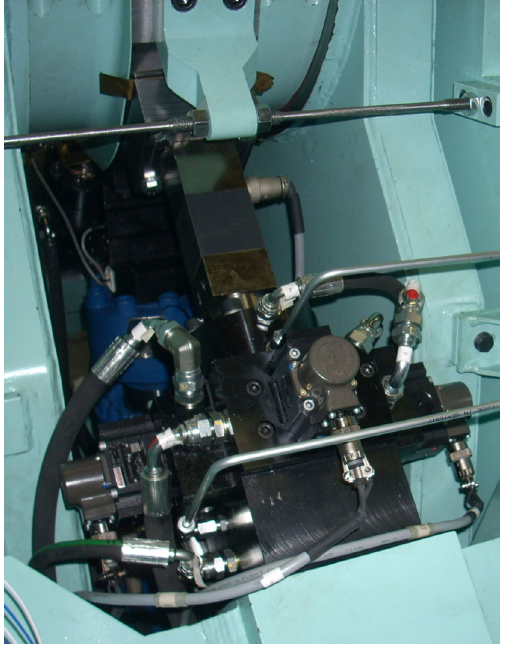
Fig. 4 Image of one of two dynamic actuators of tilting pad journal bearing test rig. Fig. 5 Image of tilting pad journal bearing test